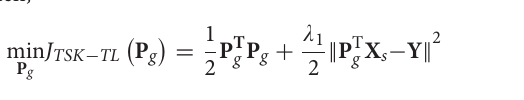
TABLE 2 | Structure of experimental datasets.